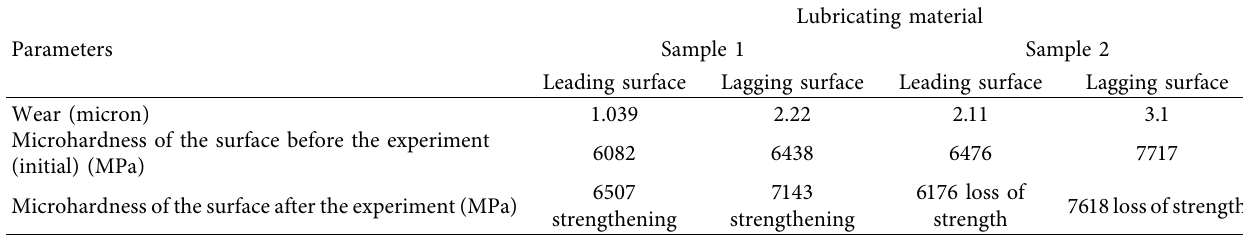
Table 4: Indicators of wear and microhardness of friction